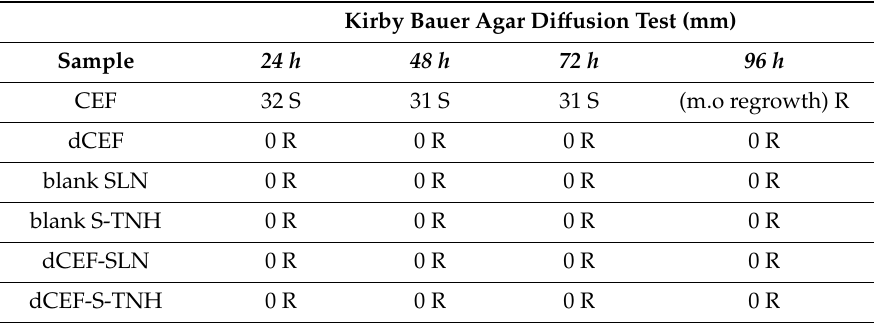
Table 4. Antimicrobial susceptibility test (Kirby Bauer test).